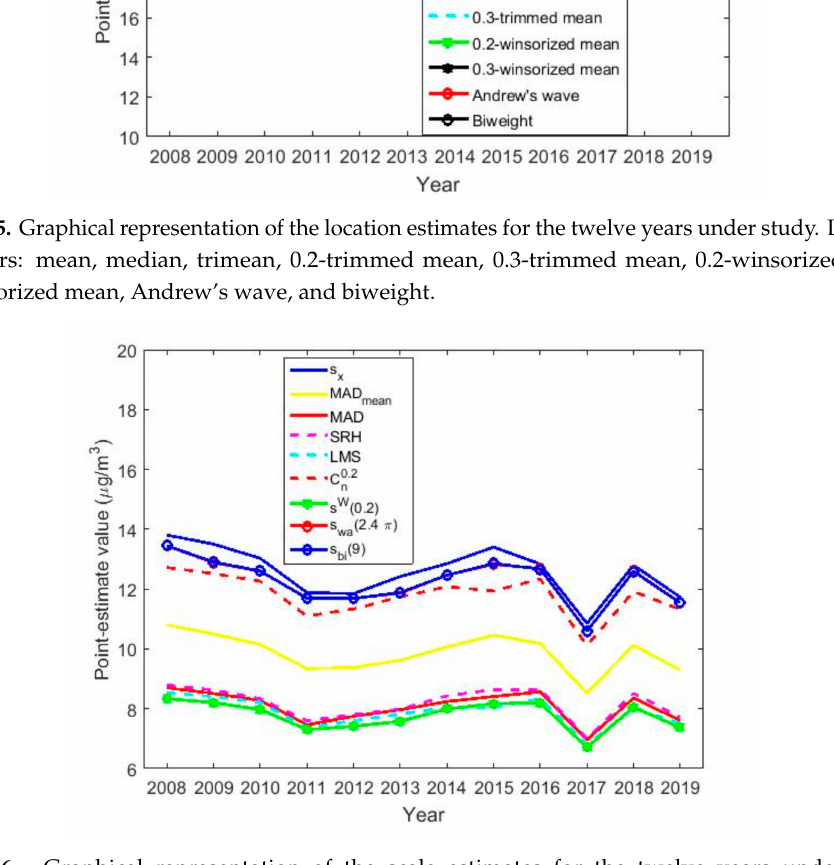
Figure 16. Graphical representation of the scale estimates for the twelve years under study. Scale estimators: sample standard deviation ( s x , mean absolute deviation ( MAD mean ) , median absolute deviation ( MAD ) , one-half of the fourth-spread ( SRH ), least median squares ( LMS ), estimator based on a subrange ( C α n ), winsorized standard error ( s W ( 0.2 ) ), Andrew’s wave ( s ω a ( 2.4 π ) ), and biweight ( S bi ( c )